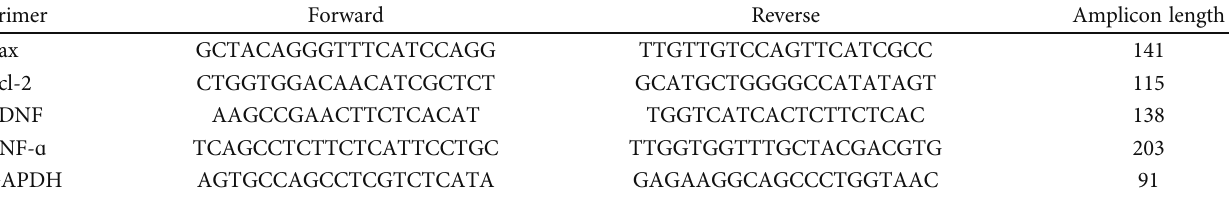
Table 1: Bax, Bcl-2, BDNF, TNF- α , and GAPDH primer sequences used for RT-PCR